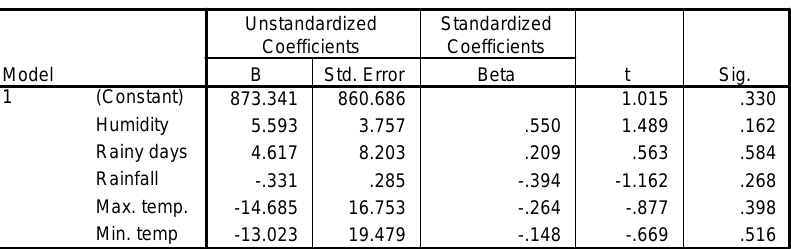
Regression Table for Insect Abundance and Environmental